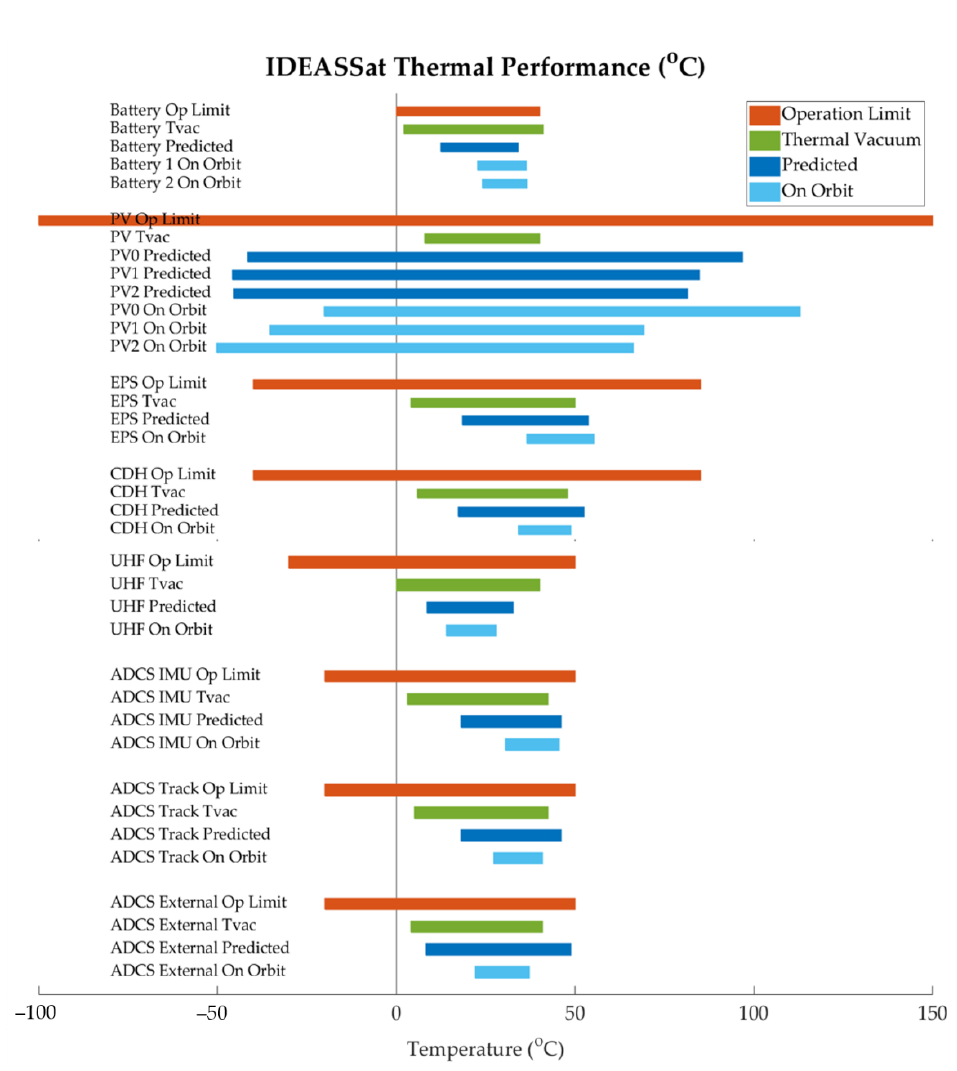
Figure 21. The temperature range of the satellite subsystems. Orange: operating limit temperature; green: environmental test temperature range; dark blue: thermal analysis temperature prediction; light blue: actual on-orbit ambient temperature. Temperatures shown from top to bottom are for: EPS battery module (Battery), solar panels (PV) including body mounted panel (PV0) and deployable panels (PV1 and PV2), UHF transceiver (UHF), electrical power subsystem (EPS), command and data handling (CDH), ADCS inertial measurement unit (IMU), star tracker (Track), and exterior (External).